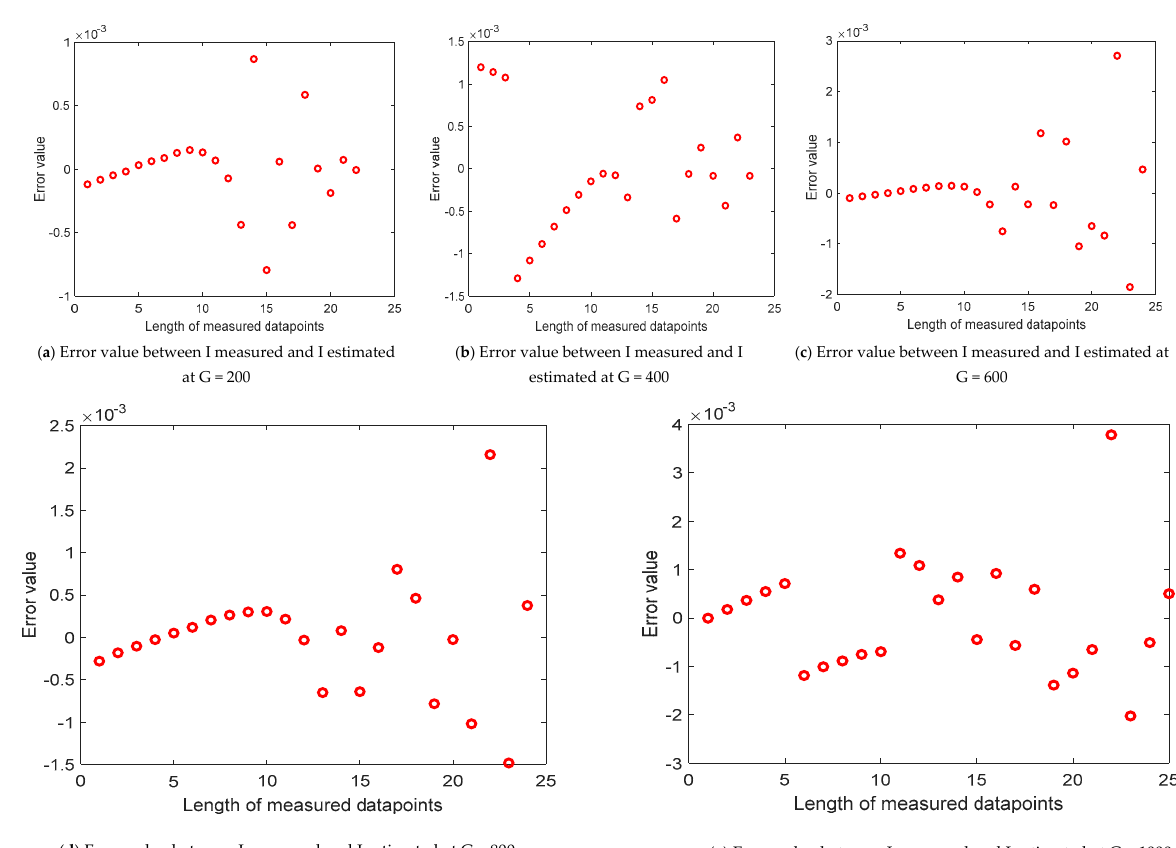
Figure 14. Depiction of the principal characteristics on SM55 module.